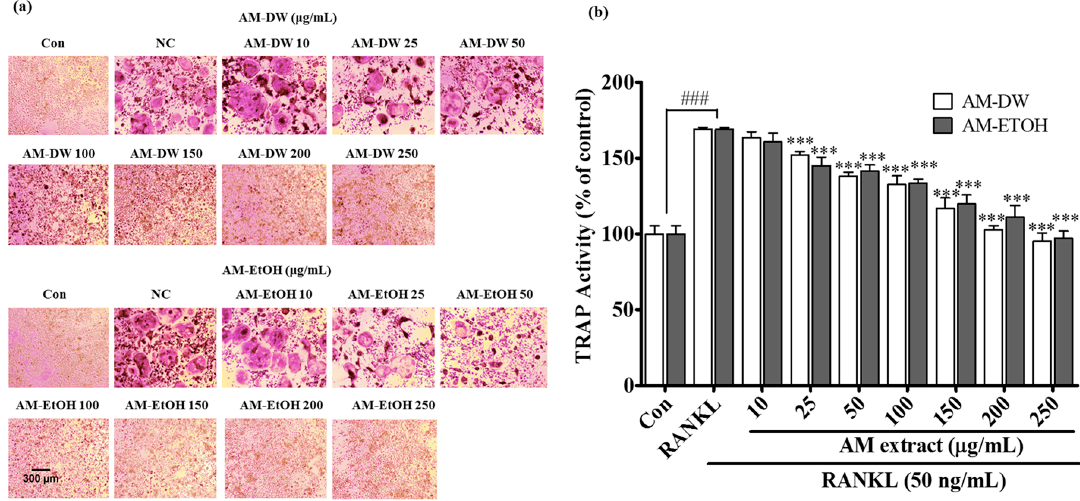
Figure 4. Inhibitory properties of AM extracts on differentiation and TRAP activity ( a ) Inhibitory effects of AM extracts on RANKL-induced round-shaped osteoclast formation originated from RAW 264.7 cells. Cells were exposed to RANKL (50 ng/mL) in the presence and absence of AM extracts for 5 days. The cells were fixed and stained using a leukocyte acid phosphatase (TRAP) kit. Con; positive control, (which was not treated), RANKL; negative control, (which was treated with only RANKL), Sample treated group; RANKL+ sample. TRAP positive multinucleated osteoclasts were visualized in 40× magnification under light microphotography; ( b ) Inhibitory effects on TRAP activity of RANKL induced osteoclast in RAW 264.7 cells by AM extracts . Cells were exposed to RANKL (50 ng/mL) in the presence and absence of AM extracts for 3 days. TRAP activity was measured by TRAP solution assay. All data are presented as the mean ± SD of three independent experiments performed with n = 3. Statistical analysis were done by Comparing, Con (positive control, which was not treated) vs. RANKL (negative control, which was treated with only RANKL, ### p < 0.001) and RANKL vs. sample treated group (*** p < 0.001).